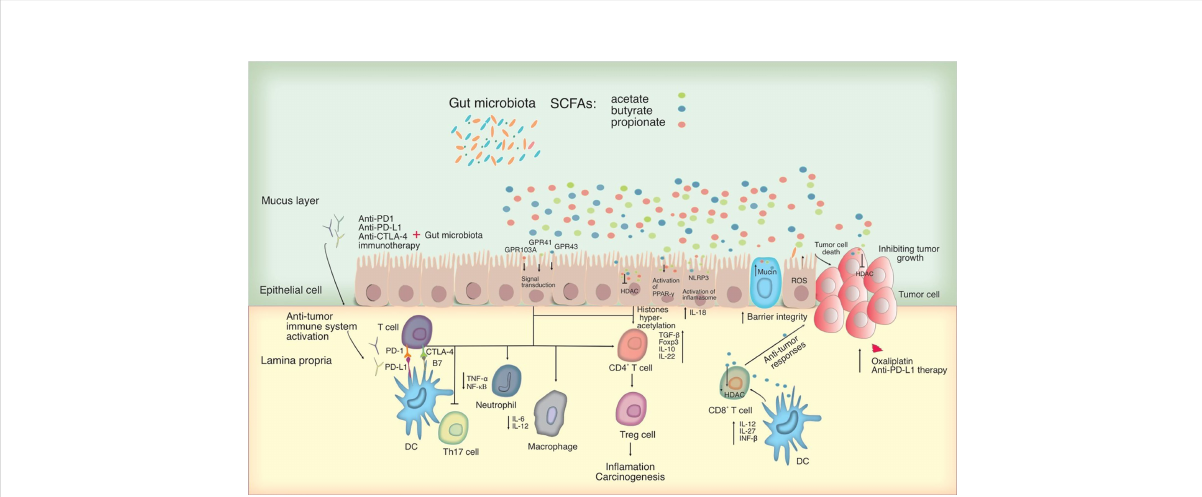
FIGURE 2 Potential mechanisms for microbiota-mediated immunomodulation in tumor cells. SCFAs, which primarily consist of acetate, butyrate, and propionate can act as an HDAC inhibitor and in fl uencing directly on cancer cells. By interacting with particular GPCRs including GPR41, GPR43 and GPR109A, SCFAs can have an effect on the immune system, leading to upregulation of immunosuppressive IL-10 and transforming growth factor-beta (TGF- b ), downregulation of pro-in fl ammatory cytokines in macrophages and neutrophils, and inhibition of differentiation towards T helper type 17 (Th17) cells, thereby suppressing in fl ammation and carcinogenesis. SCFAs activate the in fl ammasome and the PPAR- g pathway, promoting mucin production and improving epithelial integrity. SCFAs were also shown to activate the NLR family pyrin domain containing 3 (NLRP3) in fl ammasome, modulating the production of IL-18, which protects epithelial integrity. Signi fi cantly, SCFAs, in particular butyrate, may alter CD8 + T cell antitumor responses by in fl uencing DC signaling pathways involving IL-12, IL-27, and IFN- b , all of which have an impact on tumor combination therapy. In this fi gure, the role of PD-1 and CTLA-4 in the priming and effector phases of anti-tumor immune responses is shown. Anti-CTLA-4 blocking antibodies may thereby restore T cell priming in lymph nodes, whereas PD-1 signaling inhibition may allow T cells to operate as tumor effectors. Other cell types in the tumor microenvironment, such as DCs, may also express PD-1 and hence be impacted by PD-1 inhibition. Blocking PD-1 and CTLA-4 may in fl uence T helper cell pro fi les directly or indirectly by changing the microbiota. HDAC,